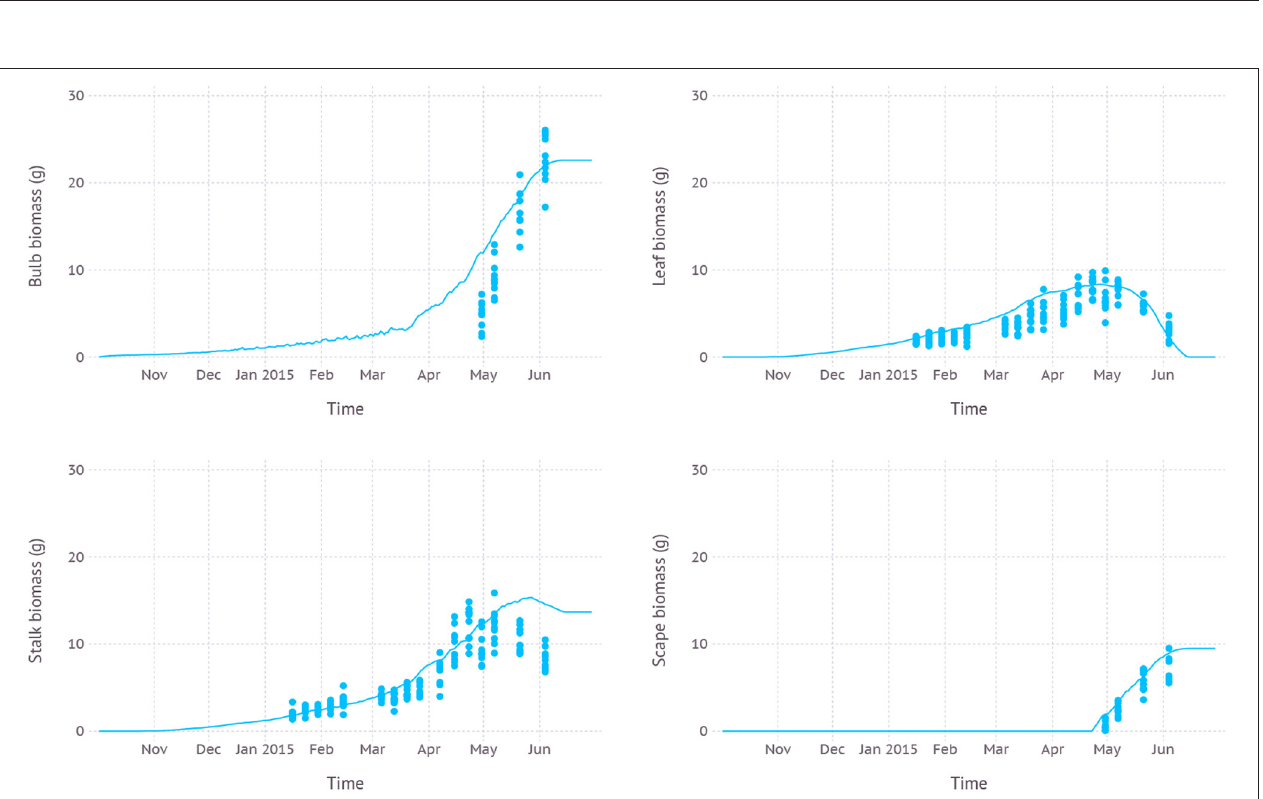
FIGURE 5 | Biomass allocation to leaf, bulb, stalk, and visible portion of scape simulated over time compared with measurements from dataset D1 which was from field measurements and primarily used for evaluating new parameters.